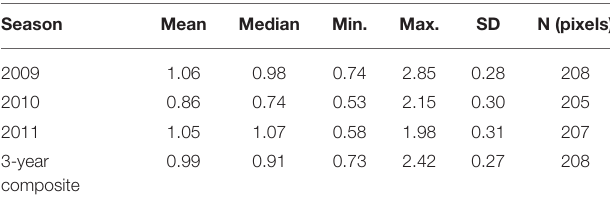
TABLE 4 | Comparison of TSM concentration per transect derived from summer seasons 2009–2011 and a 3-year summer composite.